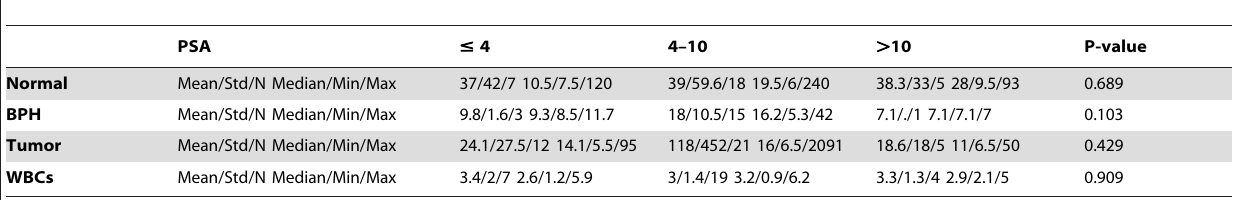
Table 3. Comparison of mtDNA content in normal, BPH, tumor, and WBCs between different levels of PSA.